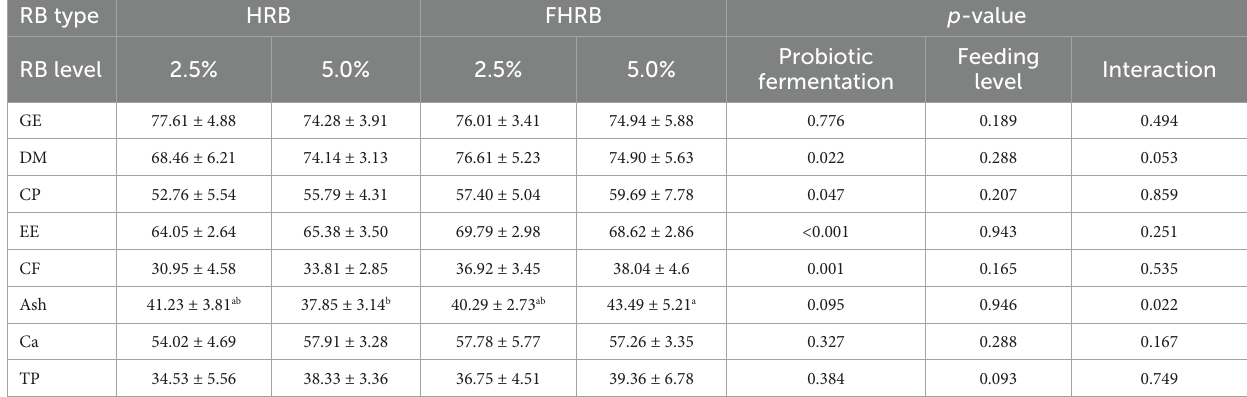
TABLE 3 Effects of RB type and feeding level on apparent digestibility of nutrients in laying hens.